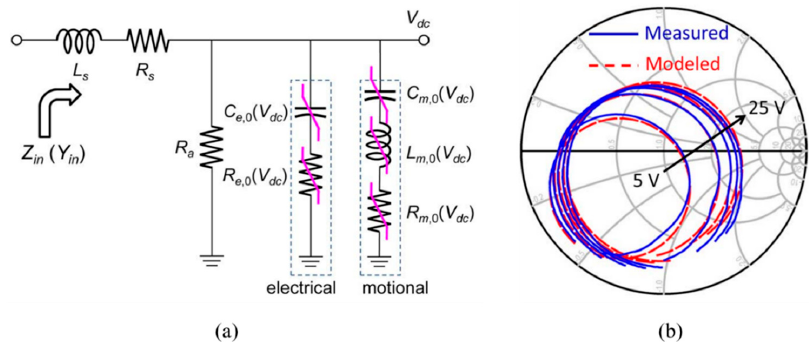
Figure 4. ( a ) Nonlinear MBVD model. ( b ) The measured and modeled reflection coefficients on the Smith chart with DC bias voltages. Reproduced with permission from [10].